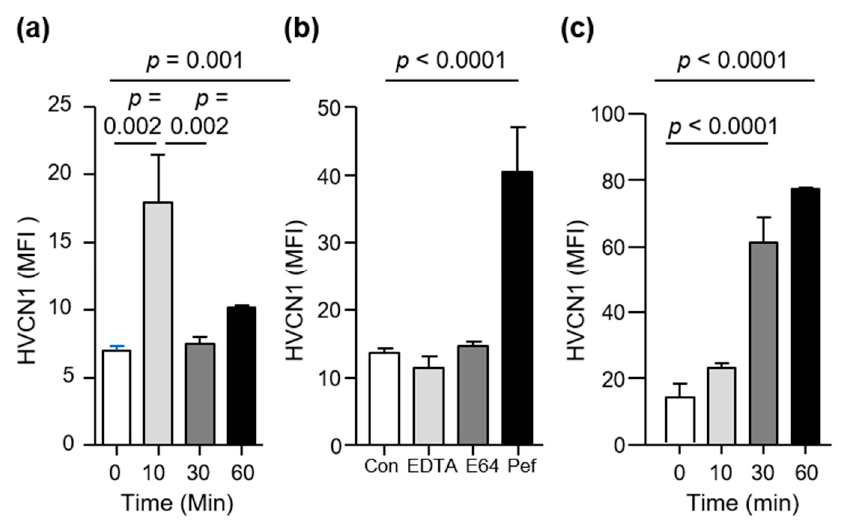
Figure 2. HVCN1 is reduced on activated neutrophil plasma membranes by serine proteases. ( a ) Time course of TNF- α /fMLP (10 ng/10 µ M) neutrophil activation with HVCN1 membrane expression assessed by flow cytometry. Significantly increased abundance of HVCN1 at 10 min compared to 0 min ( p = 0.001, n = 6, one-way ANOVA, post hoc Tukeys’ test). ( b ) TNF- α /fMLP activation of neutrophils for 30 min (Con) in the presence of nonspecific protease inhibitors EDTA, E64 or pefabloc (Pef). Pef treatment resulted in significantly increased abundance of HVCN1 ( p < 0.0001, n = 3, one-way ANOVA, post hoc Dunnetts’ test). ( c ) Time course of neutrophil activation in the presence of Pef. Inclusion of Pef resulted in increased levels of HVCN1 ( p < 0.0001, n = 6 technical repeats, one ‐ way ANOVA, post hoc Tukeys’ test).